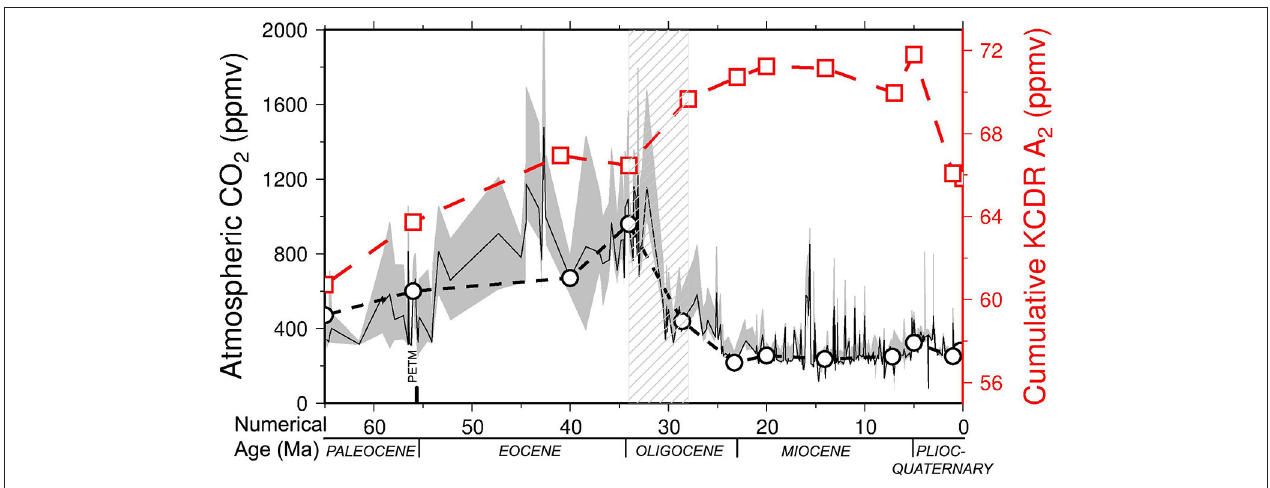
FIGURE 4 | Cenozoic cumulative (i.e., inorganic—CaCO 3 – and organic) carbon dioxide removal carbon dioxide removal over 1000 yr (KCDR) (red line, open squares) for model A 2 = 600,000 km 2 , compared with the values of atmospheric CO 2 reported by Beerling and Royer (2011) (solid black line, gray confidence band), including CO 2 selected values at the key times used to calculate plate reconstructions and coastline lengths (dashed black line, open circles). Note the general match between CO 2 decrease and KCDR increase due to seagrass extent as a consequence of increase of coastal length. Dashed pattern represents the Eocene-Oligocene time